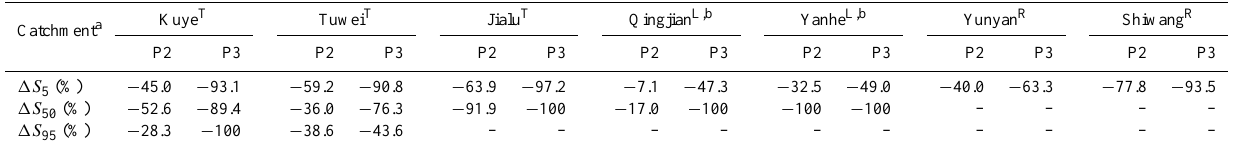
Table 6. The relative changes in high (5%), median (50%), and low (95%) of sediment load regimes in the P2 and P3 for the seven catchments, as compared to the P1.